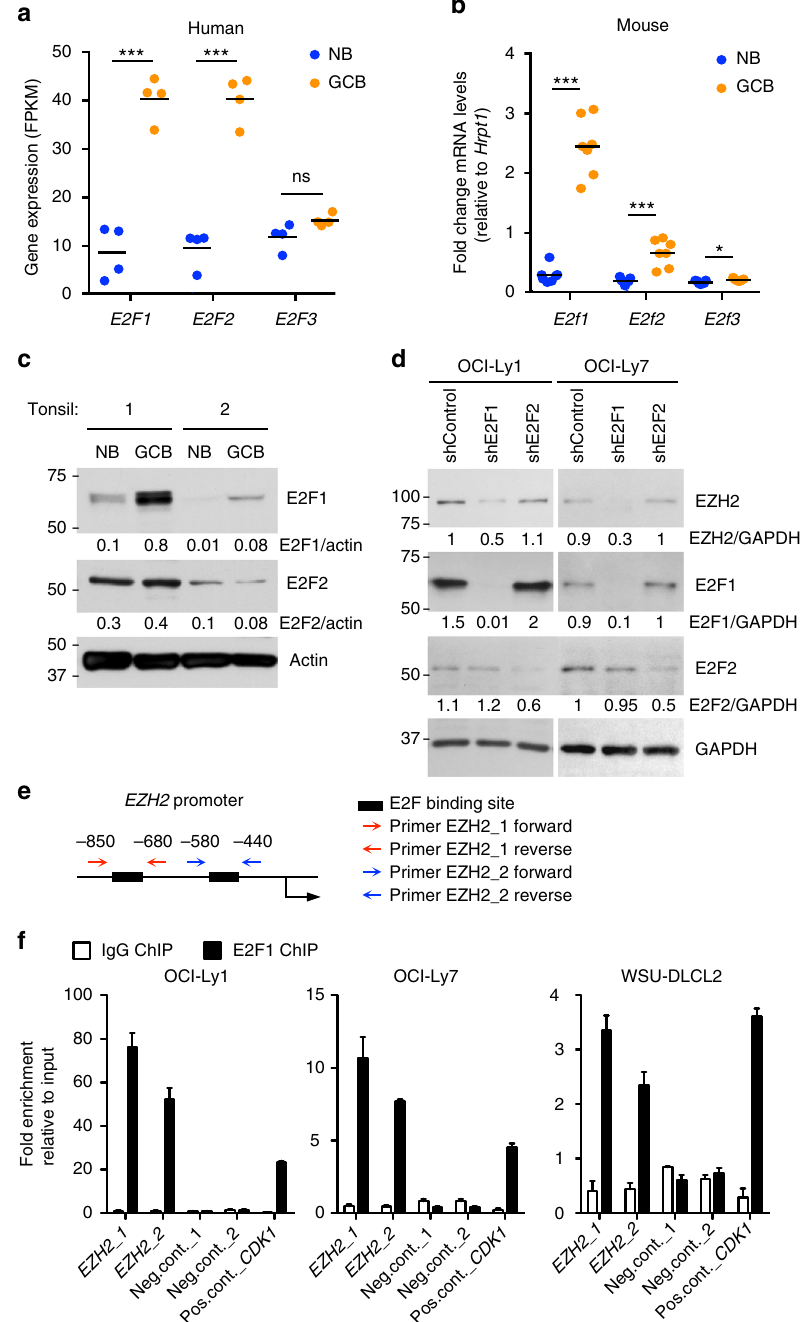
Fig. 6 E2F1 induces the expression of EZH2 in GC B cells. a Expression level in FPKM of E2F genes in naive B and GC B cells from 4 human tonsils. Horizontal black lines represent mean. t test, *** P < 0.001. b RT-qPCR of E2f in GCBs (FAS + GL7+ B220 + ) and naive B cells (FAS-GL7-IgD + B220+ ) sorted from 7 WT mice. Horizontal black lines represent mean fold change mRNA levels normalized to Hprt1 . t test, *** P < 0.001. c Immunoblotting of whole cell lysates from naive B and GC B cells from two human tonsil samples. Actin was used as loading control. The western blot shown is representative of a total of fi ve tonsils analyzed. See Supplementary Fig. 6B for uncropped scans of the western blots. d Representative immunoblotting of whole cell lysates from OCI-Ly1 and OCI-Ly7 cells expressing shRNAs against E2F1, E2F2 or control. GAPDH was used as loading control. The experiment was repeated two more times with similar results. See Supplementary Fig. 6C for uncropped scans of the western blots. e Schematic representation of the genomic region corresponding to the promoter of EZH2 . The black boxes represent a region of putative E2F binding sites. Two pairs of primers were design to fl ank the putative E2F binding sites. f E2F1 and control IgG qChIP was performed in the indicated cell lines using the primers described in e . As negative control qPCR was performed using primers for two regions in chromosomes 6 and 7 where no enrichment of transcription factors was found by ChIP-seq read density in OCI-Ly1 and OCI-Ly7 cells. As positive control qPCR was performed using primers fl anking an E2F binding site at the promoter of CDK1 . Fold enrichment was normalized to the input. Values are shown as mean of technical triplicates ± SEM. The experiment shown is representative of three independent ChIPs performed with OCI-Ly1 and OCI-Ly7, and two with